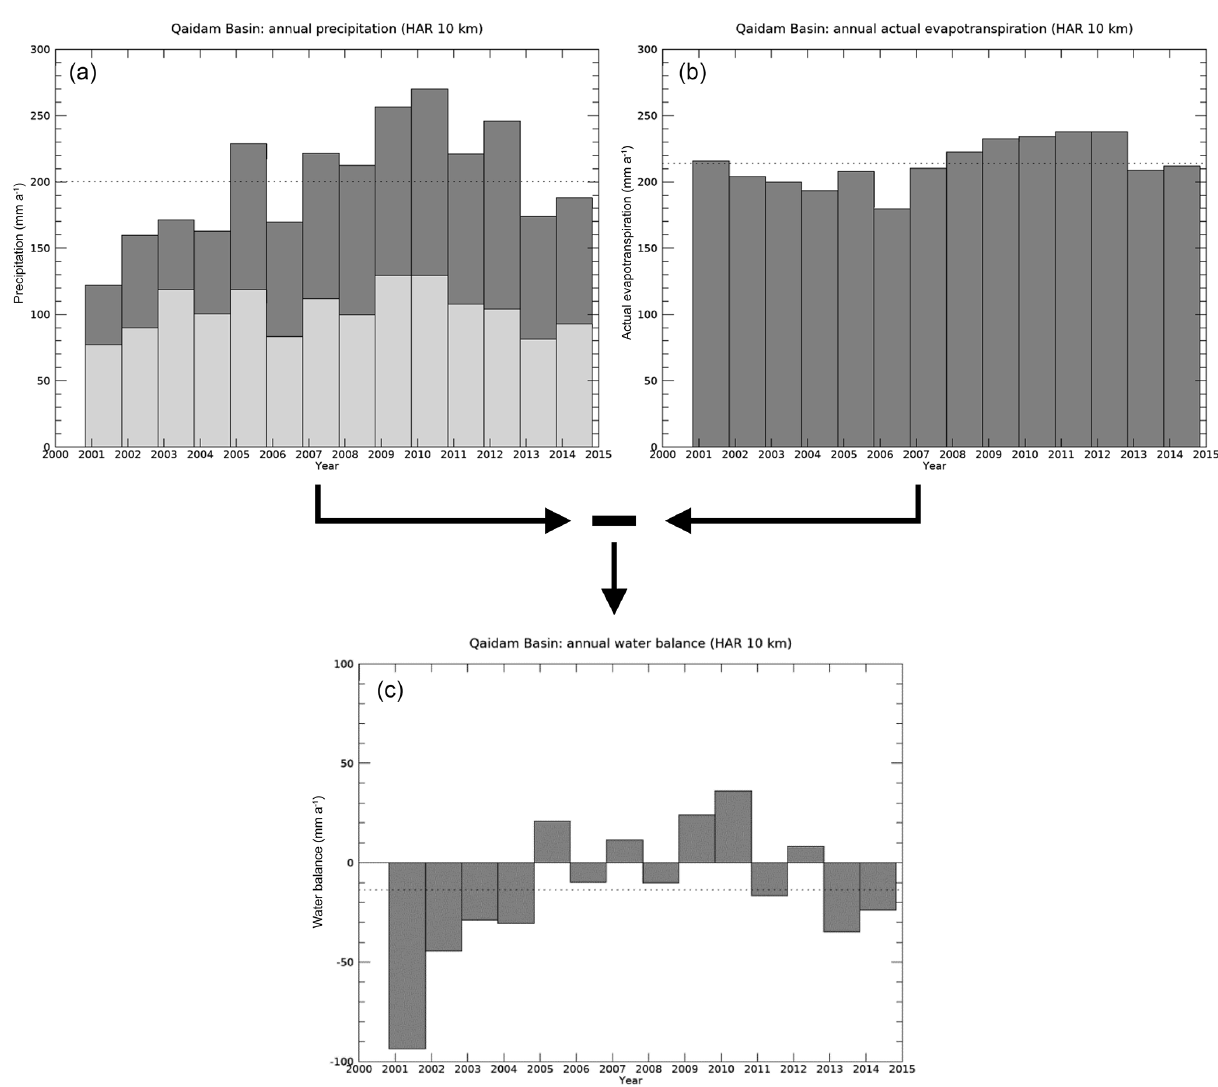
Figure 2. Annual precipitation (a) , actual evapotranspiration (b) , and water balance (c) in the Qaidam Basin (QB) during the hydrological years 2001 to 2014 derived from the HAR 10km data set. (a) Light grey bars: annual snowfall; dark grey bars: annual rainfall. Dotted lines: mean annual